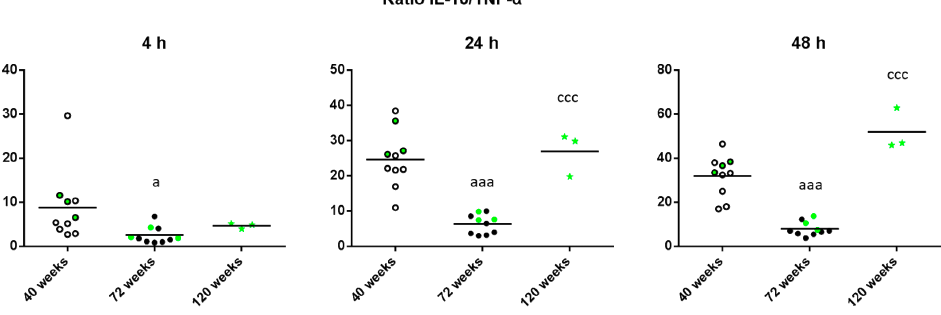
Figure 6. IL-10/TNF- α ratios of the levels of these cytokines released by peritoneal leukocytes from adult (40 weeks), old (72 weeks) and long-lived (120 weeks) mice after 4, 24 and 48 h of culture. The green points represent the values in mice that reached 120 weeks. a: p < 0.05; aaa: p < 0.001 with respect to the value in adult mice. ccc: p < 0.001 with respect to the value in old mice.